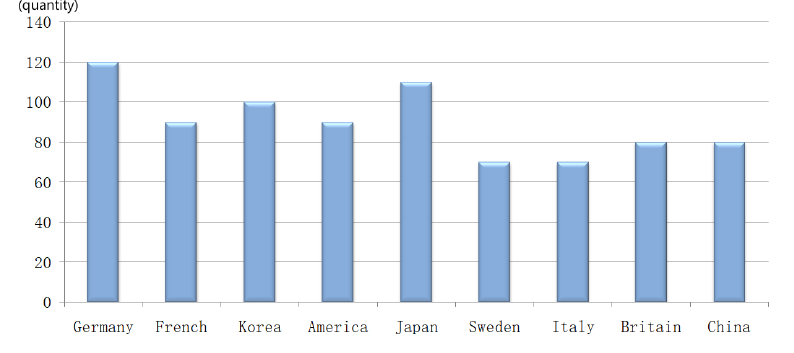
Figure 11. The number of training texts for the relation